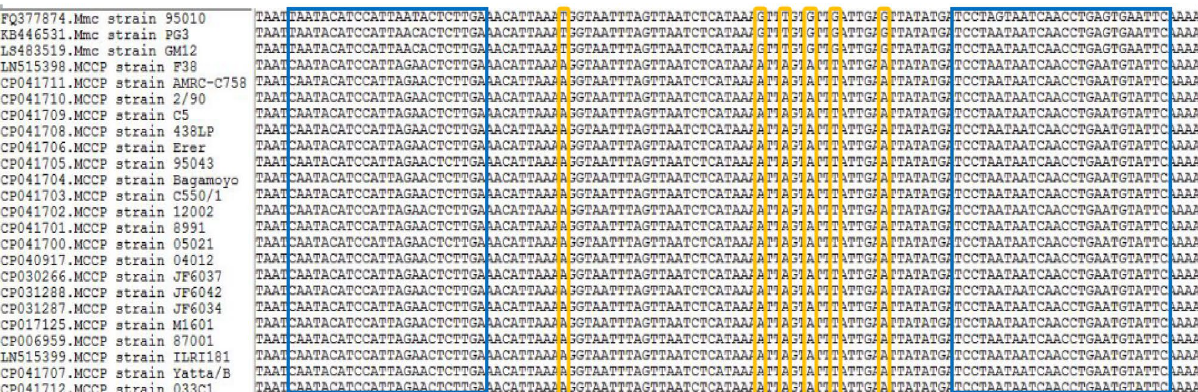
Figure 1. The design of primers for HRM. Conservation of the corresponding sequence of each primer was analysed using BioEdit sequence alignment editor v7.1.7 aligned, The corresponding sequence of each primer in all selected Mmc and Mccp isolates shown in bule colour, The different bases in all selected Mmc and Mccp isolates shown in yellow